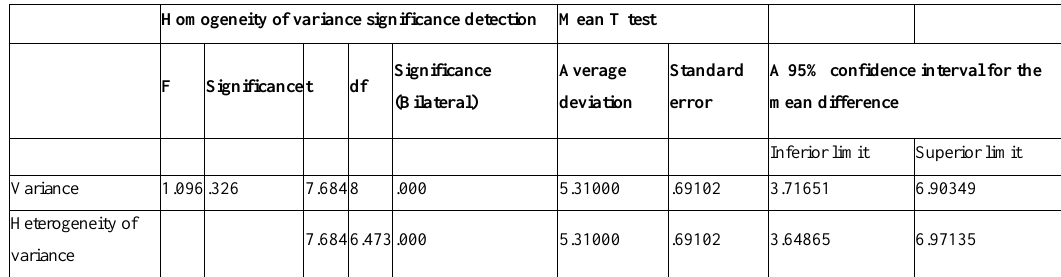
Table 2 Independent sample T test results (fixation time)